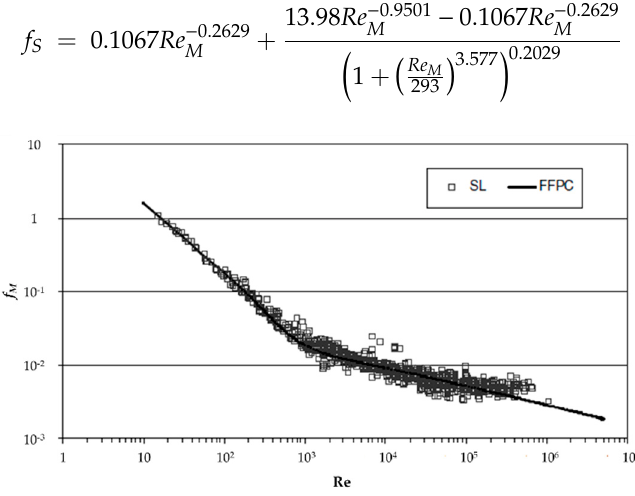
Figure 4. Simulated three-dimensional velocity profiles (in m/s) at the interface [33].